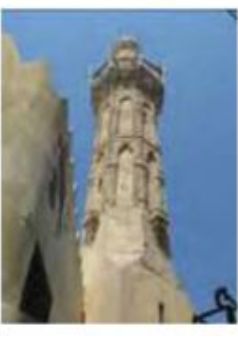
Figure 9. Mosque Al-Mahalli